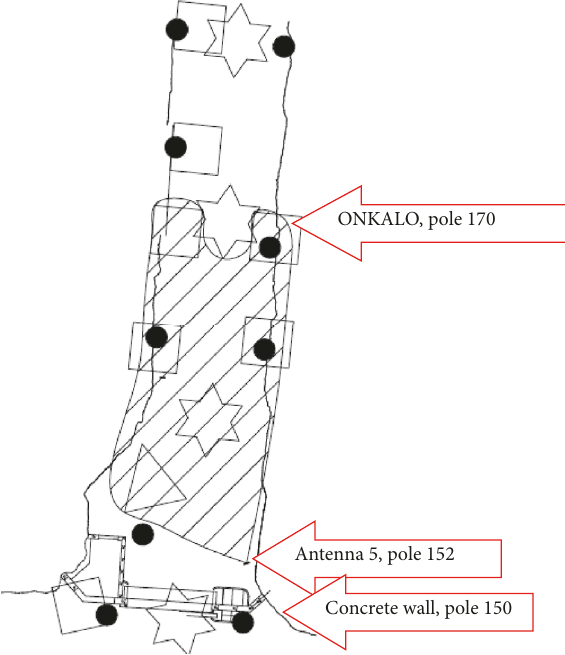
Figure 22: Antenna 5 MRRR area.